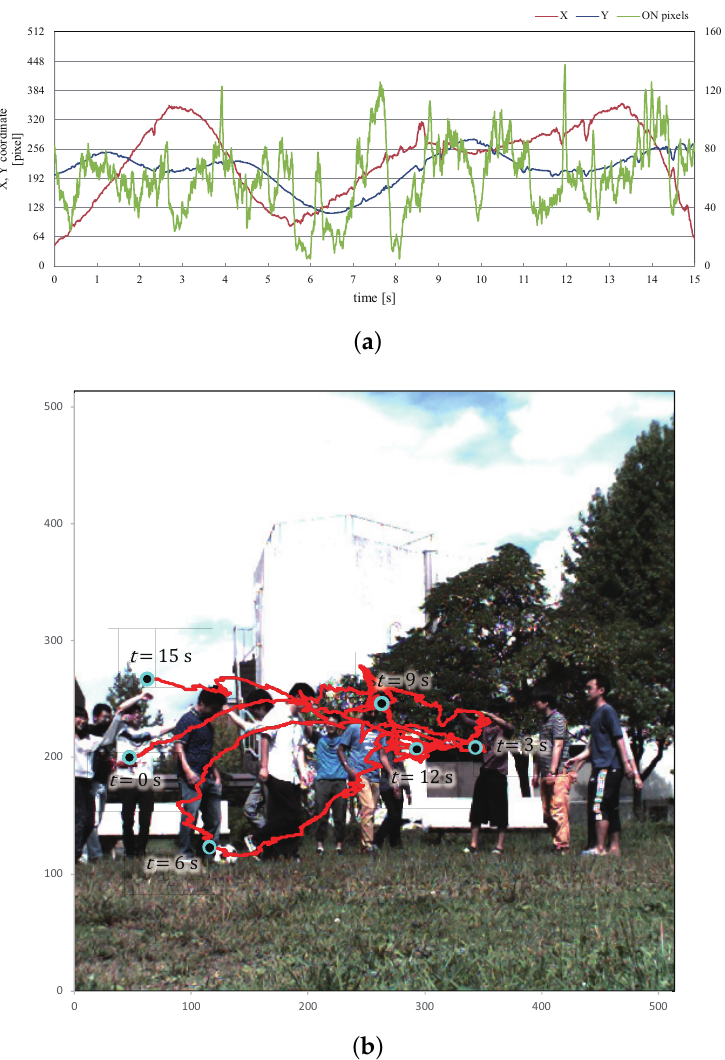
Figure 22. xy trajectory of extracted vibration region in “trees-and-building background” experiment. ( a ) x - and y -coordinates and number of pixels; ( b ) xy